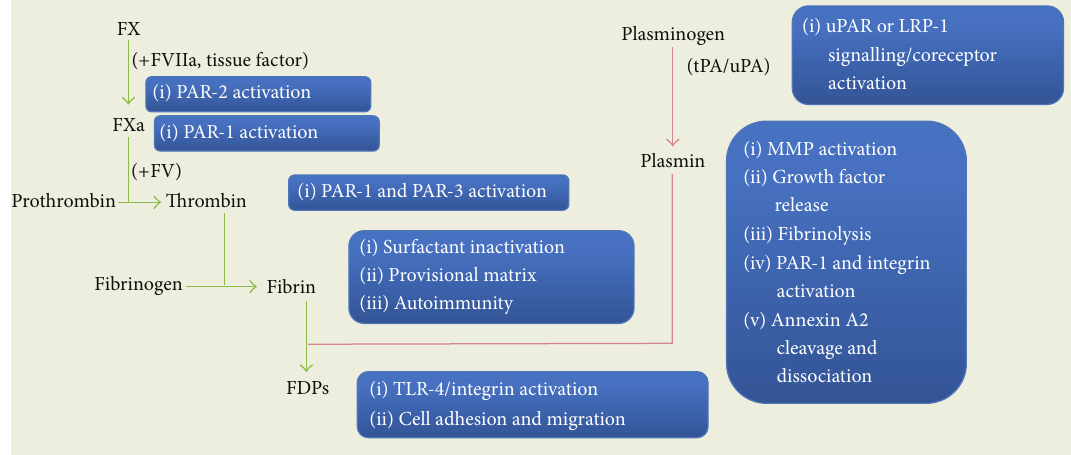
Figure 1: The proinflammatory and proremodelling actions of coagulant and fibrinolytic proteases. In tissue injury and disease, the proteases FXa, FVIIa, thrombin, plasmin, uPA, and tPA not only participate in extravascular coagulation (green pathway) or fibrinolysis (red pathway), but also mediate inflammation and tissue remodelling. The cell-mediated actions of the individual proteases can overlap (i.e., PAR-1 activation by FXa, thrombin, and plasmin) and/or be interconnected (i.e., the generation of FDPs by both coagulation and fibrinolytic